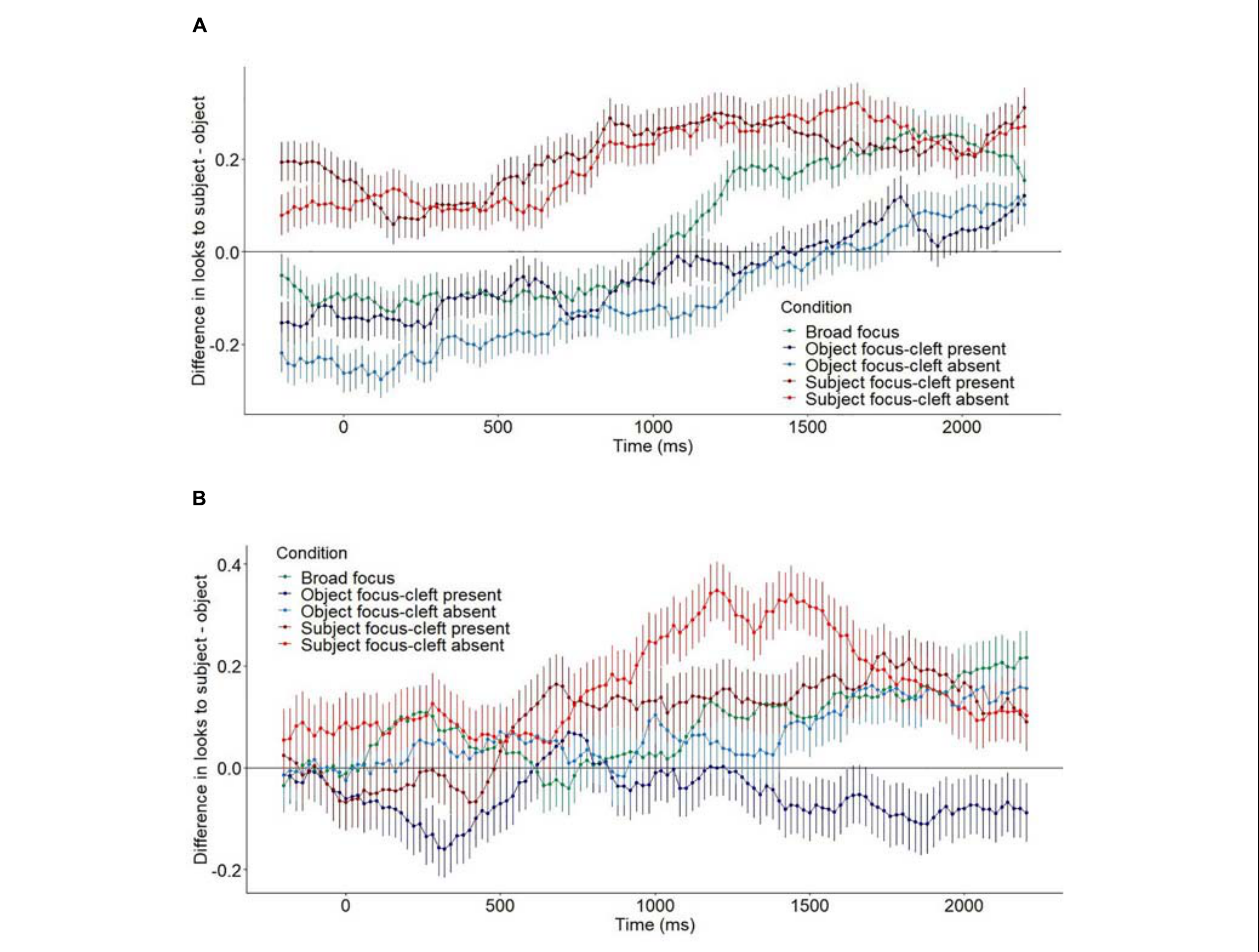
FIGURE 2 | Fixation probabilities to the subject (the object subtracted from fixations to the subject, per condition [by time in ms; 0 ms = pronoun onset]). Top: adults (A) ; bottom: children (B) . A positive score indicates subject preference whereas a negative score indicates object preference. Error bars indicate standard